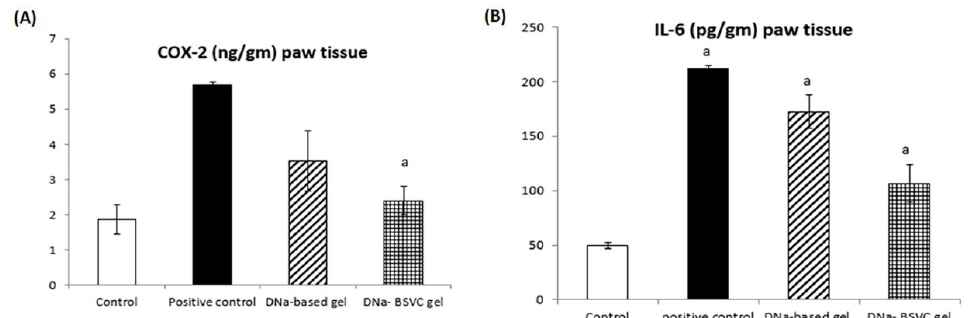
Figure 10. Treatment effects of DNa-based gel and DNa-BSVC gel on COX-2 in paw tissue homogenate of CA-induced paw edema in rats ( A ) and IL-6 (in paw tissue homogenate of CA-induced paw edema in rats ( B ). Statistical analysis and the significance of difference between groups’ means were performed via one-way ANOVA, and after that a Tukey–Kramer multiple comparisons test at p > 0.05. The values are expressed as inhibitory rate (%) for 6 rats data identified as mean ± SEM. a: significantly different from normal control.